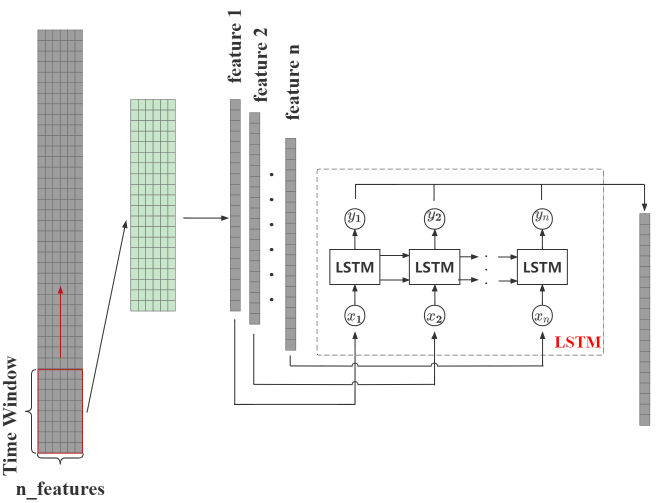
Figure 4. Structure of